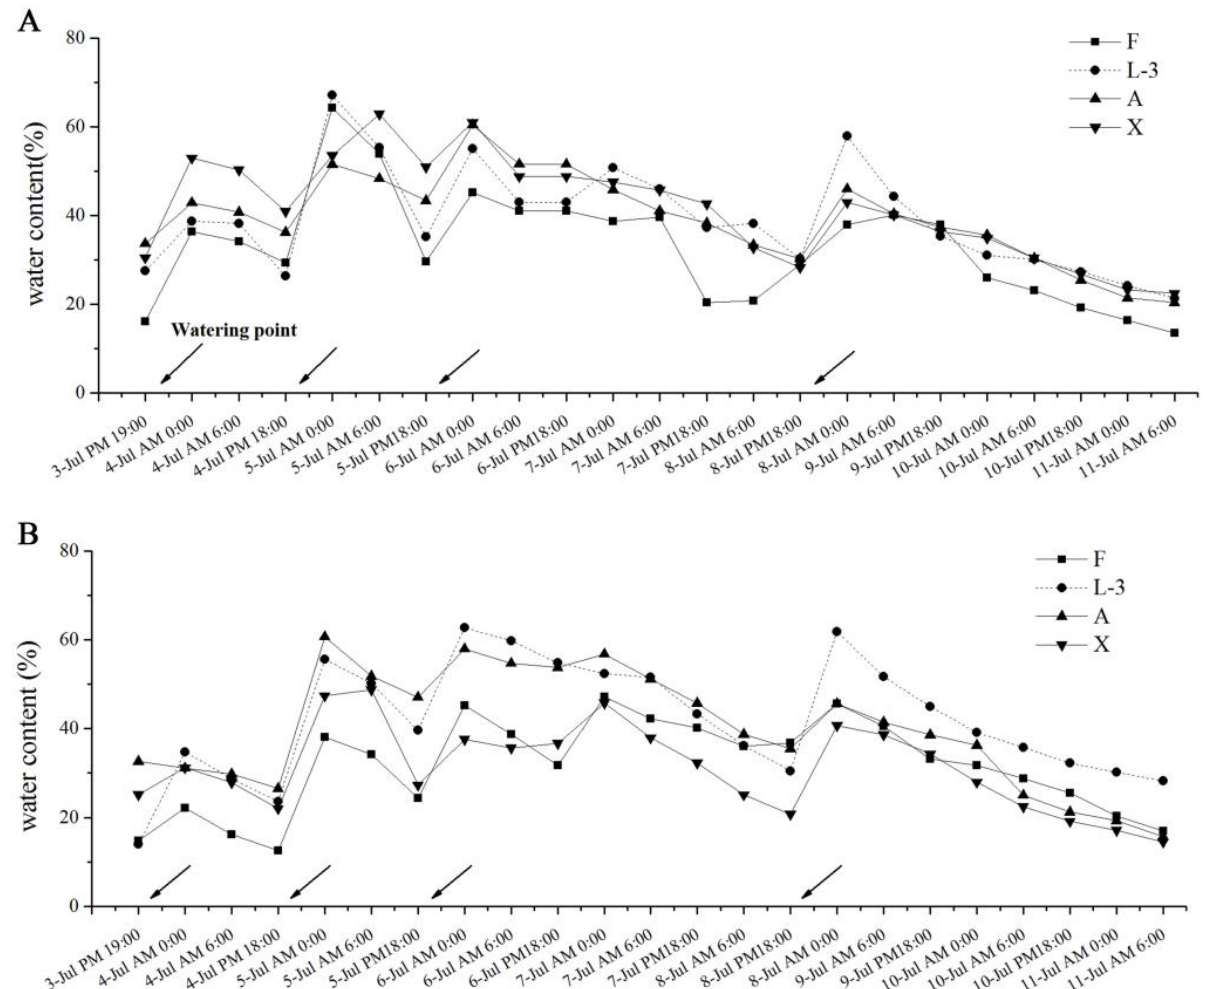
Figure 2. Soil water content under WW (irrigation) conditions. ( A ), top pots. ( B ), bottom pots. The arrows indicate the time points of watering. F, L-3, A, and X indicate different potato cultivars. F, Favorita cultivar. L-3, Longshu No.3 cultivar. A, Atlantic cultivar. X, Xindaping cultivar.